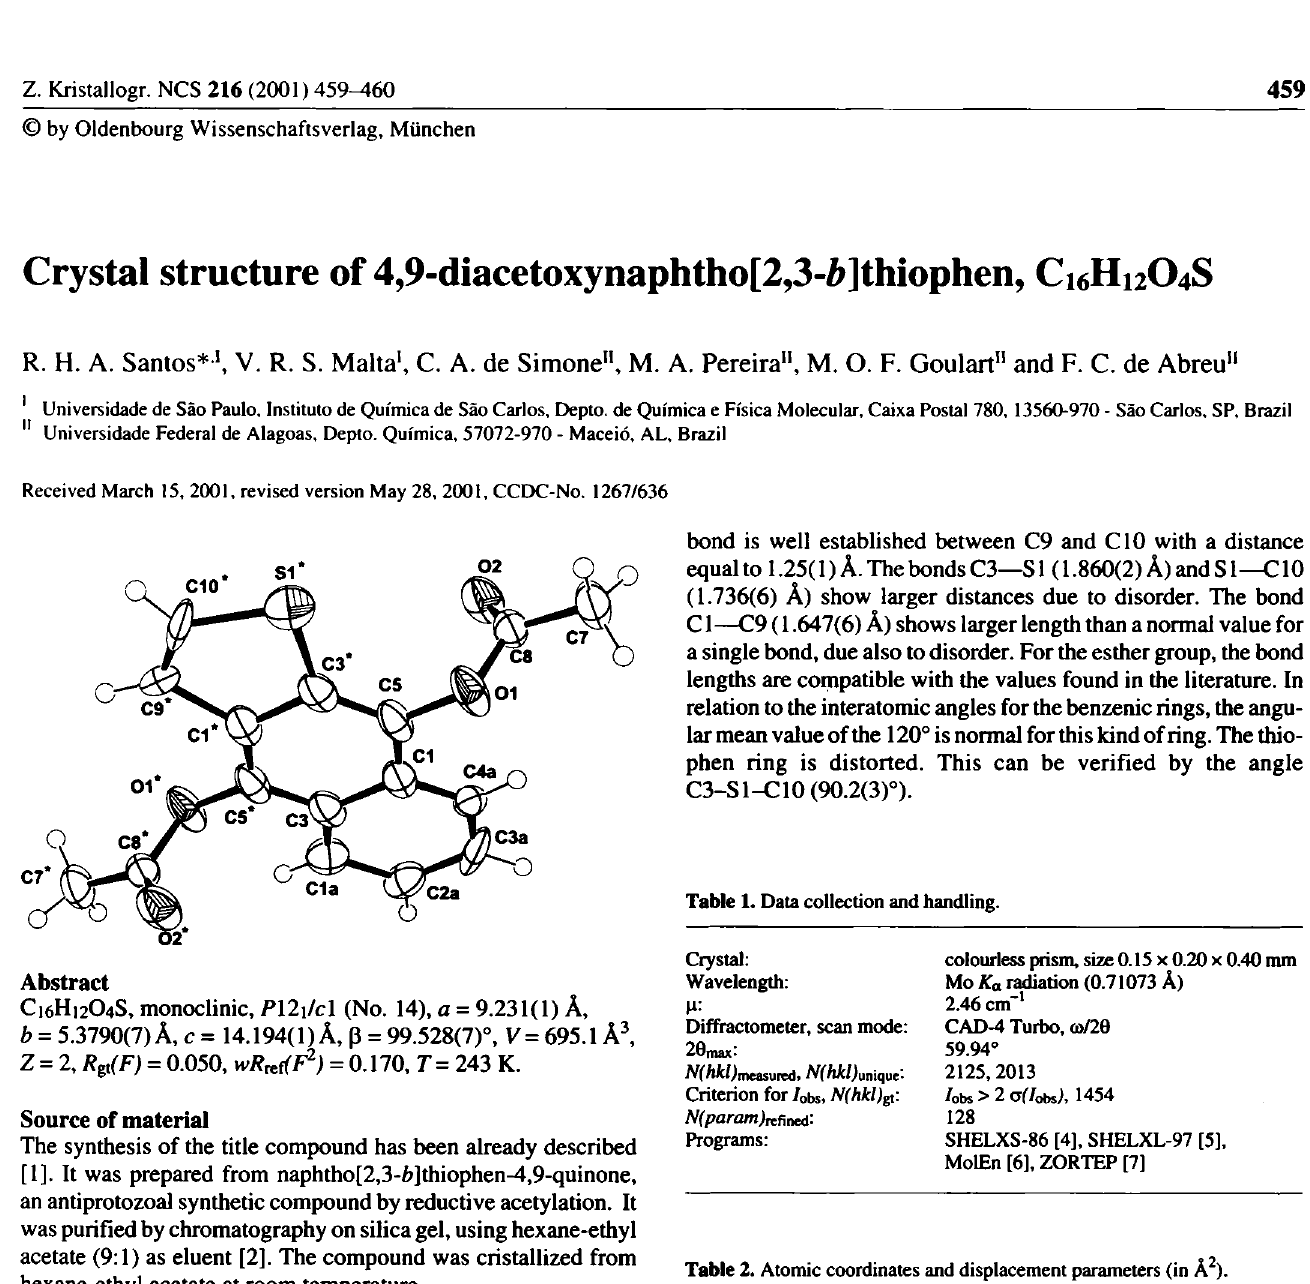
Table 2. Atomic coordinates and displacement parameters (in Ä 2